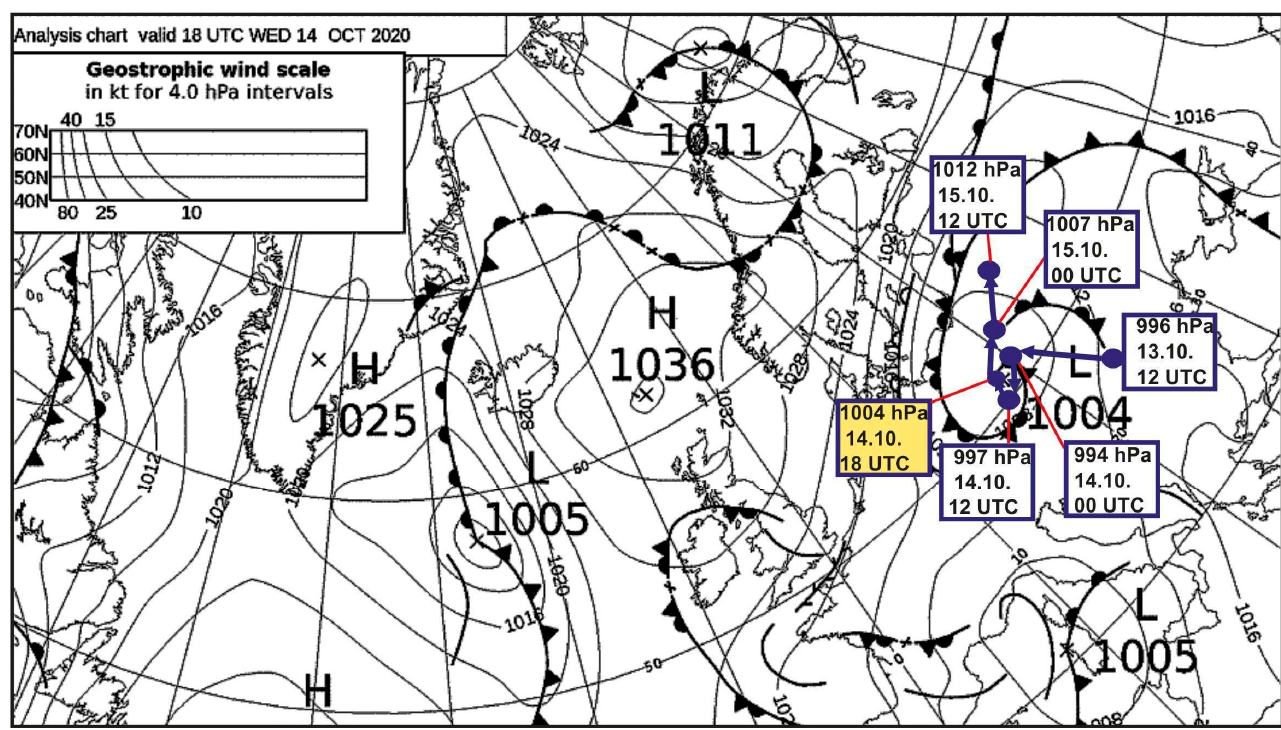
Figure 2. The course of the low pressure system between 13 and 15 October 2020, along with the main synoptic situation